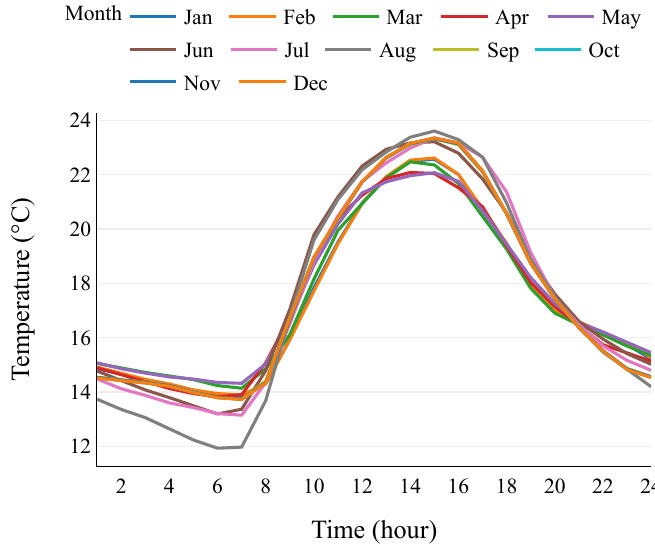
Figure 7. Daily average temperature for one year by